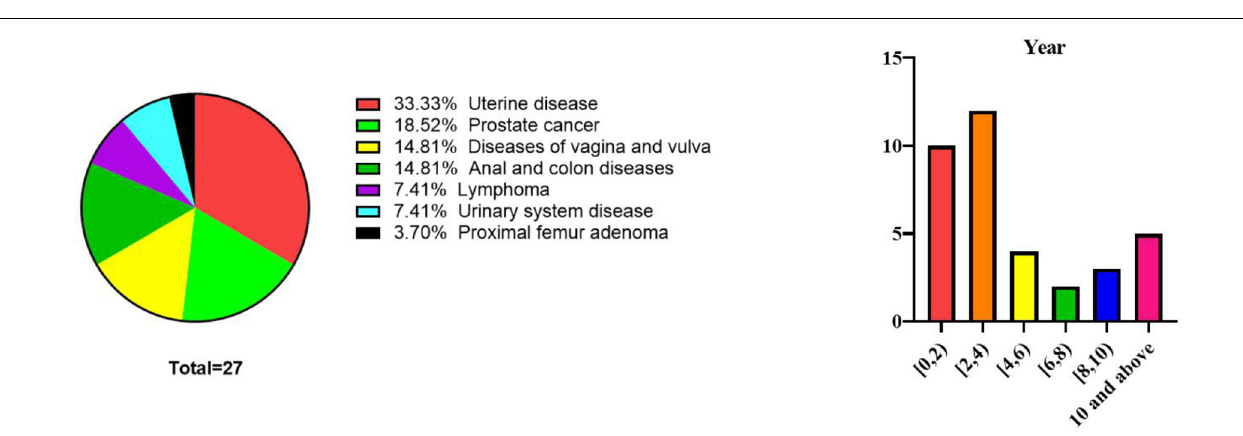
FIGURE 4 | Distribution of diseases that necessitated radiotherapy in all 27 patients and time interval between radiotherapy and onset of osteoradionecrosis (In cases of bilateral hip joint osteoradionecrosis, each joint was counted separately: n = 36 cases, excluding 2 cases with no reported interval